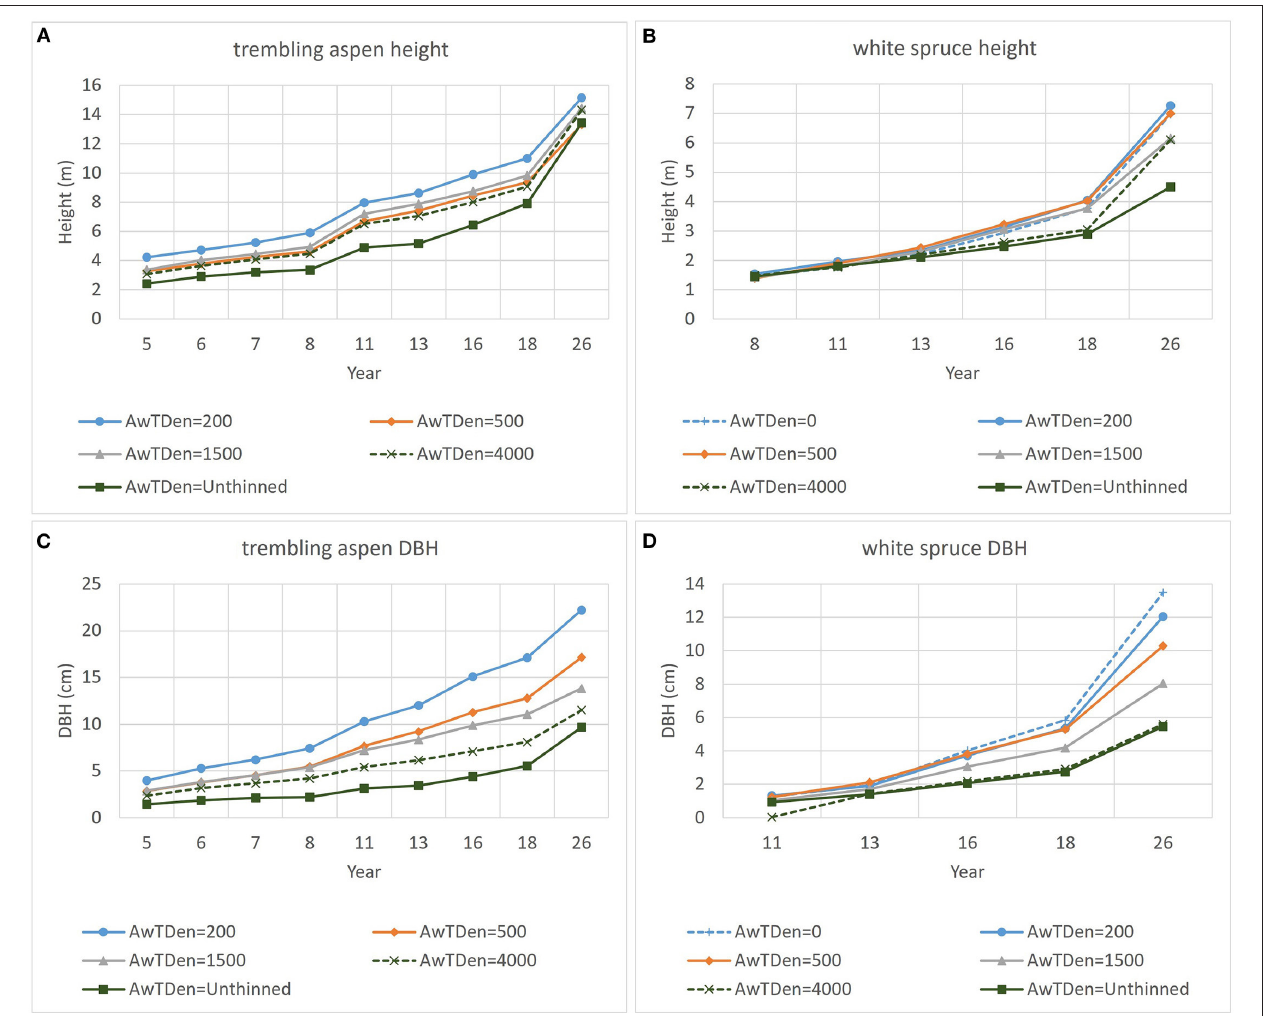
FIGURE 2 | Trends in average height (A,B) and DBH (C,D) for aspen and white spruce for the six aspen densities (AwTDen; values are in trees ha − 1 ).